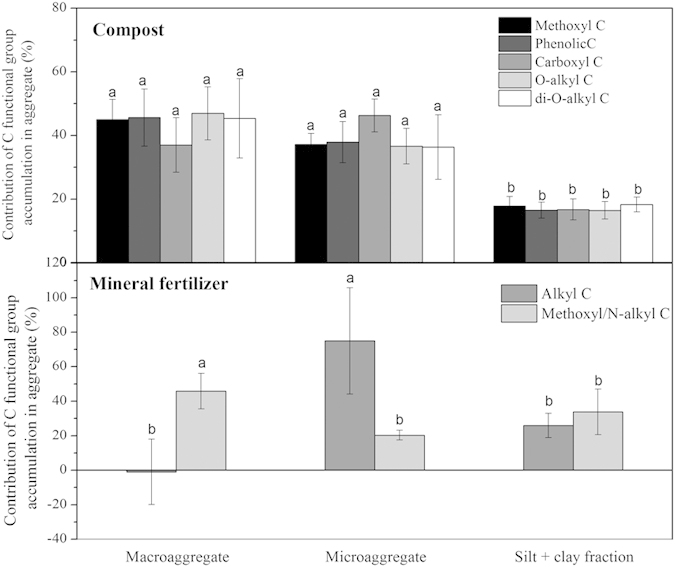
Contribution of the increased amounts of main organic C functional groups in aggregates, as affected by the application of compost (average for HCM and CM) and mineral fertilizer (average for NPK and NP).Different lowercase letters indicate significant differences between aggregates for the same C functional group (Tukey’s test, P < 0.05, n = 4).